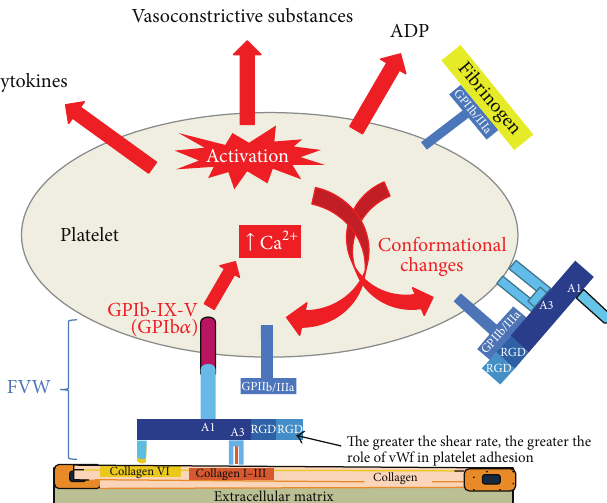
Figure 6: Diagram illustrating the role of von Willebrand factor (vWf) in platelet adhesion. High flow rates induce conformational changes in vWf allowing interaction of its A3 domain with matrix collagen. This induces a conformational change in the A1 domain, thereby allowing interaction with glycoprotein (GP) platelet receptor Ib-IX-V. This interaction stimulates calcium release, subsequent platelet activation, and subsequentconformationalchangeofthefibrinogenreceptor(GPIIb/IIIa),whichcaninteractwithfibrinogenandvWftofavortheinteraction between platelets (platelet aggregation process). ADP indicates adenosine diphosphate; RGD and Arg-Gly-Asp are amino acid sequences (adapted from Badimon et al., 2009